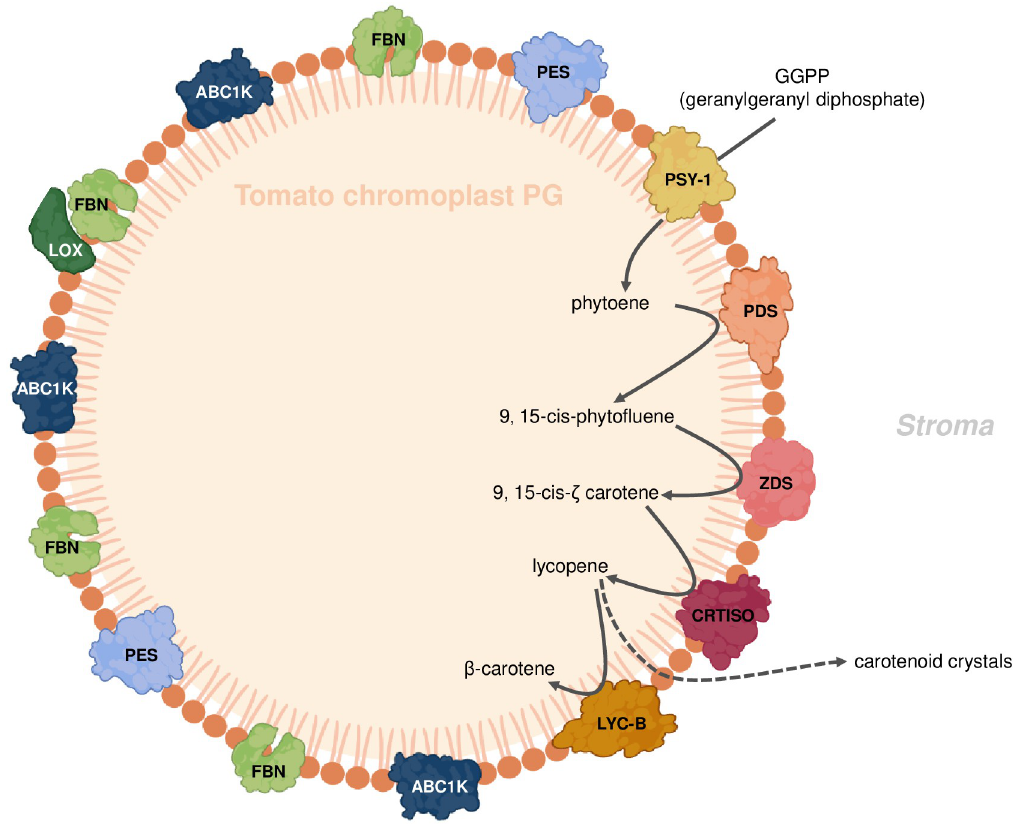
Fig 7. Carotenoid biosynthetic pathway in tomato chromoplast PG. Chromoplast plastoglobules recruit the carotenoid biosynthetic pathway enzymes: phytoene synthase 1 (PSY1), phytoene desaturase (PDS), z-carotene desaturase (ZDS), and carotenoid isomerase (CRTISO) and lycopene β -cyclase (LYC- β ) to promote carotenoid biosynthesis. Lipoxygenase (LOX) may associate with PG, FBNs have structural functions and may contribute to carotenoid sequestration in PG. Phytyl ester synthase (PES) synthesizes phytyl esters and triacyl glycerol during thylakoid dismantling and Activity of BC1 complex kinase 1 (ABC1K1) is implicated in regulation of prenyl lipid metabolism.